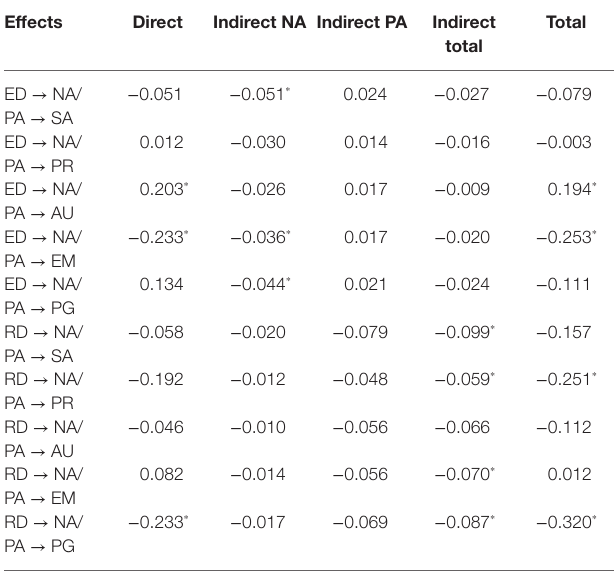
TABLE 4 | Standardized indirect and total effects of the mediation model.